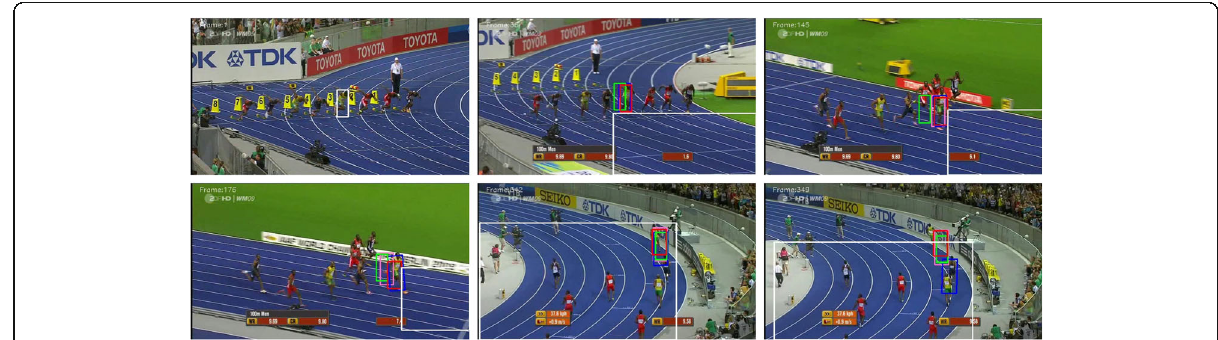
Fig. 18 The tracking results for the video “ Bolt ” using CAM-Shift (white), PF (blue), VAPF (green), M-PF (pink), and the proposed tracker (red). Par- ticle number N =